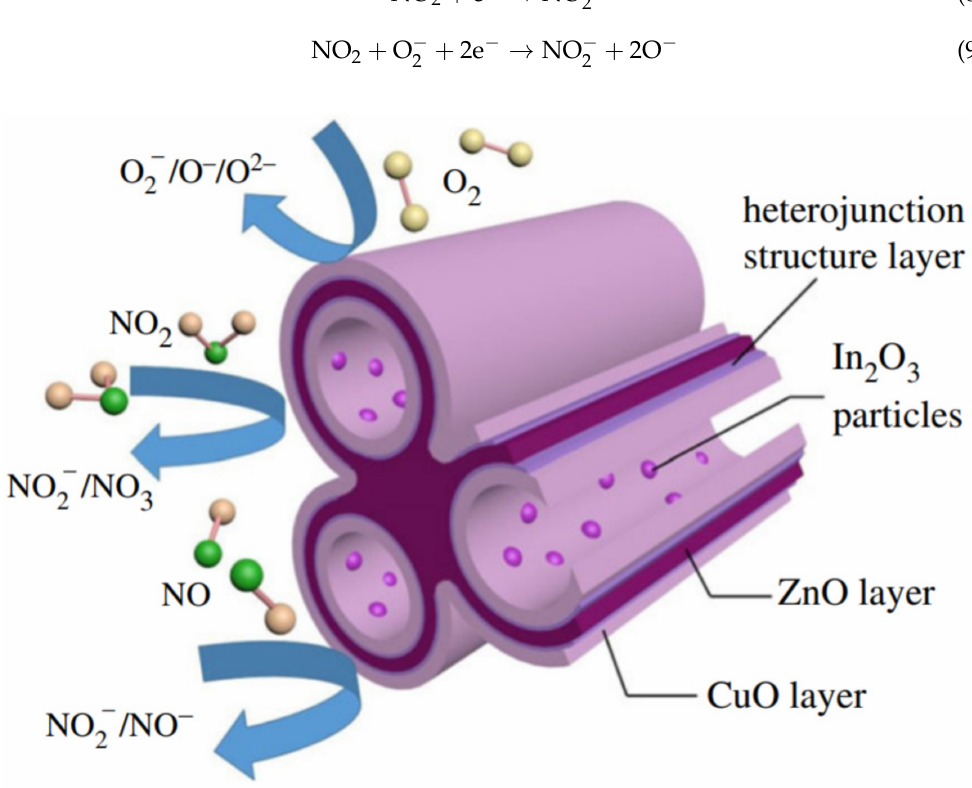
Figure 21. Schematic diagram of the sensing mechanism of a 1 wt % In 2 O 3 –CuO/ZnO sensor. Reprinted with permission from